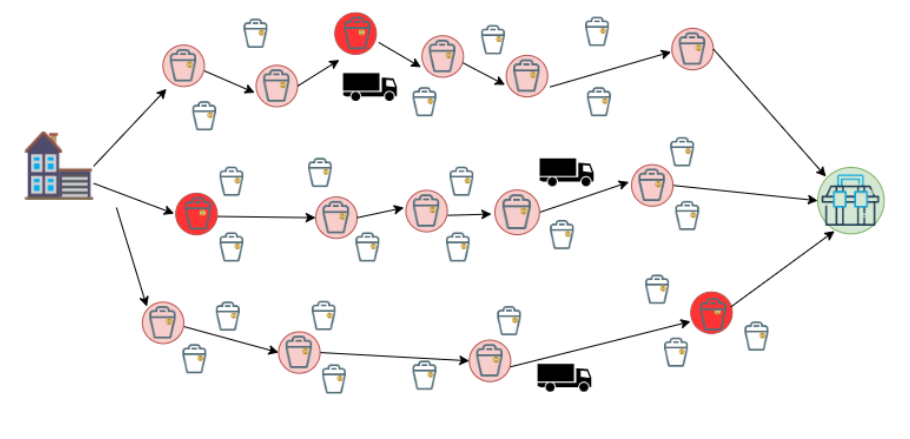
Figure 2. TOP-MV waste